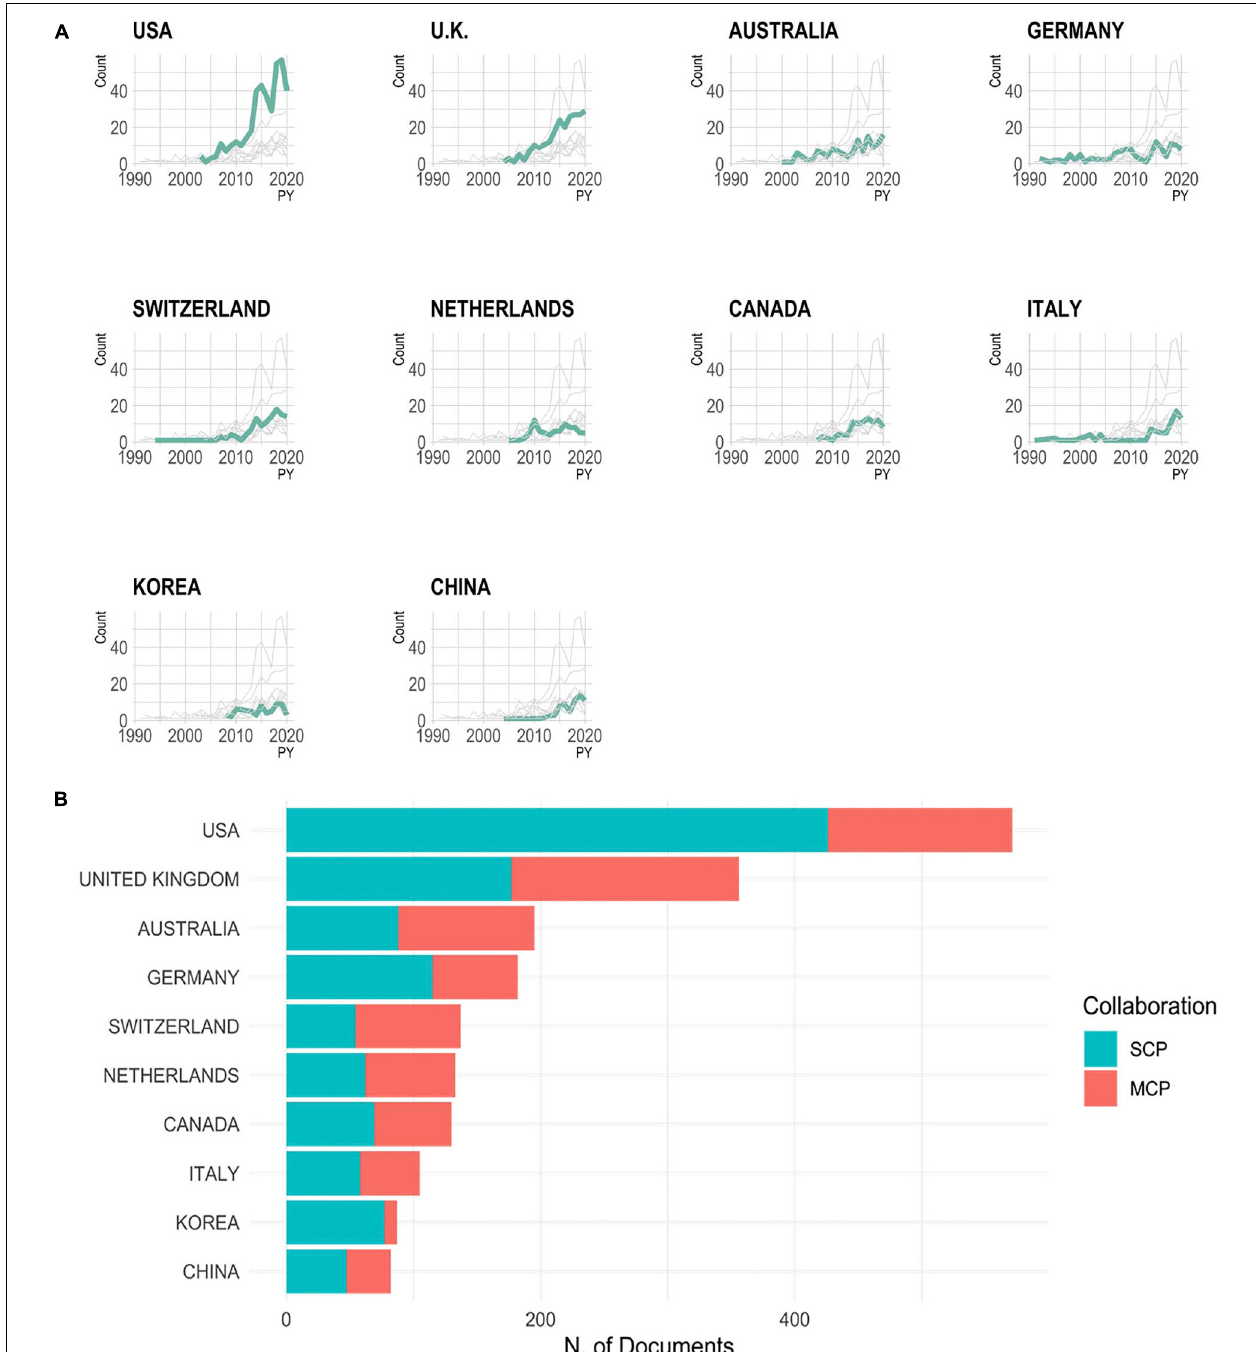
FIGURE 4 | Changes in the number of publications in each country. SCP: single country publication, MCP: multiple country